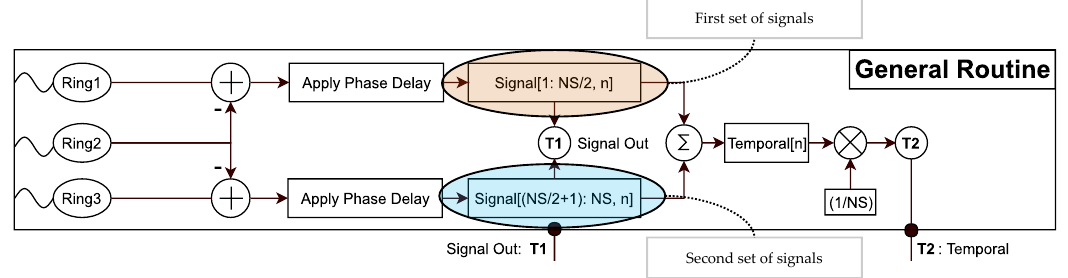
Figure 4. Flowchart of general propagation routine currently used in guided-wave devices.